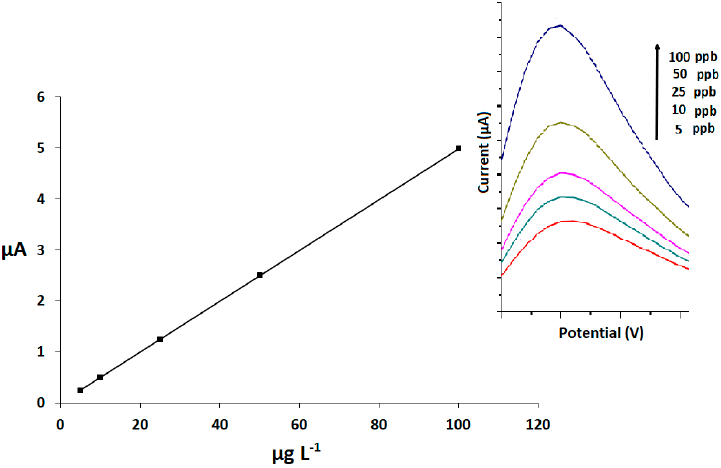
Figure 5. Calibration curve and DPV results at different concentration in the range 5—100 ng mL -1 . Table 3. Analytical parameters obtained for the Rhodamine B determination.